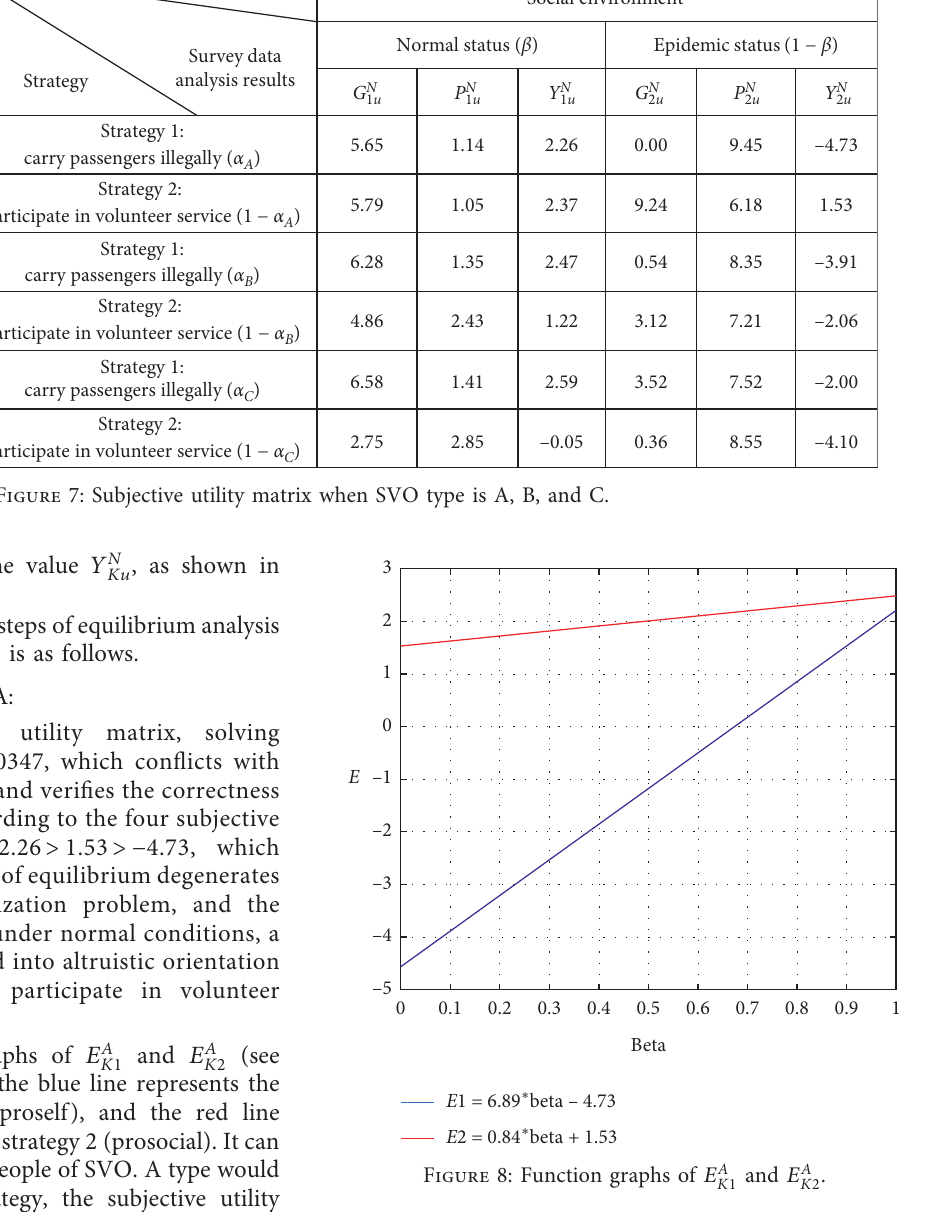
E A K 1 and K 2